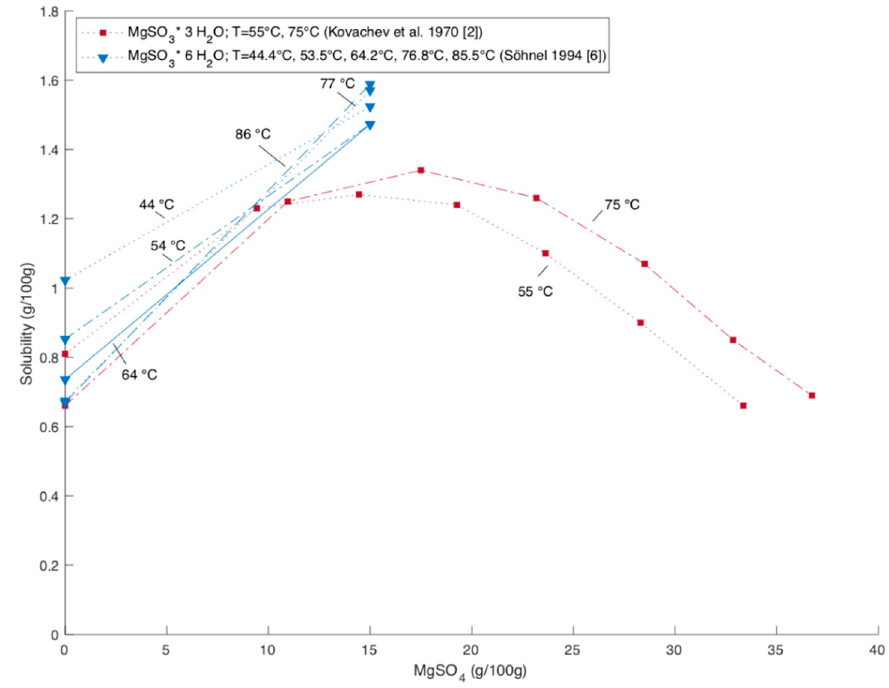
Figure 5. Solubility of MgSO 3 trihydrate over MgSO 4 content at different temperatures [2,6].